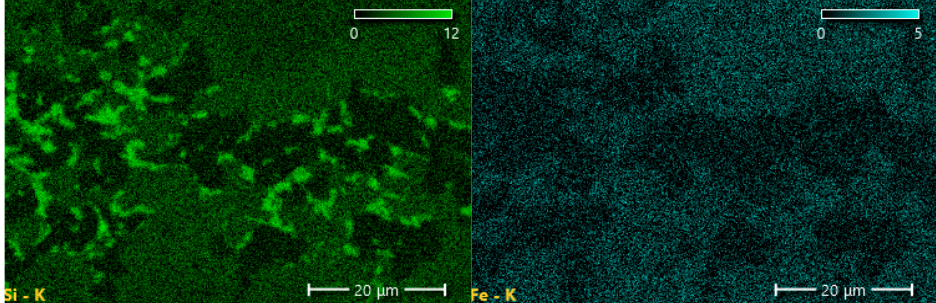
Figure 7. MZ in Hastelloy X–Palnicro 36M joint obtained after 30 min brazing at 995 °C: SEM micrograph and EDS elemental distribution maps.